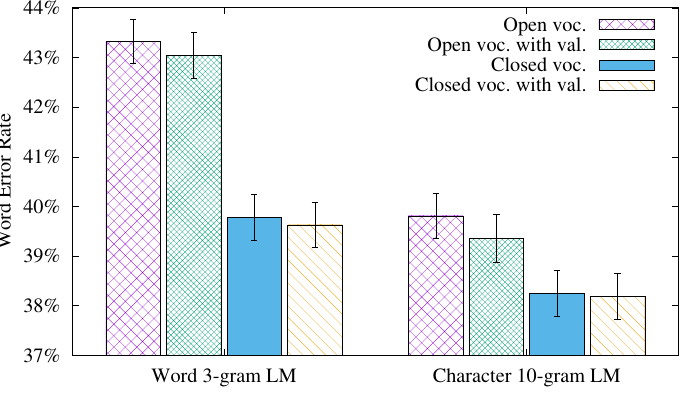
Figure 13. WER results obtained by the best word-based HMM system and the best character-based HMM system with open and closed vocabulary, with and without using the validation samples for training the